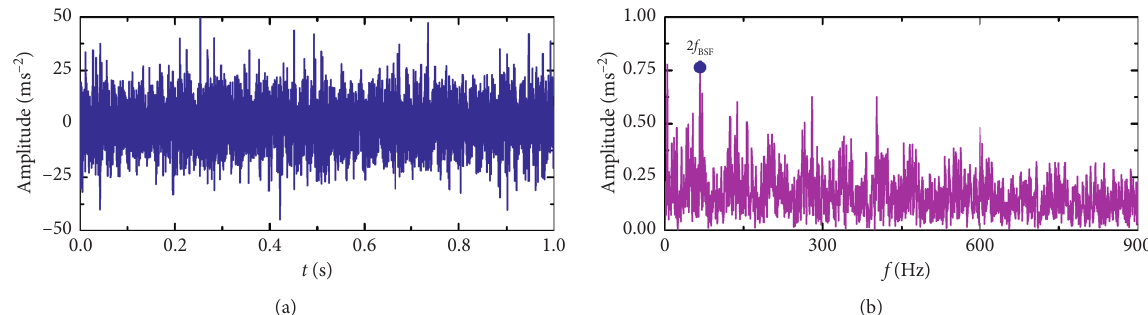
Figure 18: The collected roller fault signal and its Hilbert envelope spectrum: (a) time-domain waveform and (b) Hilbert envelope spectrum of signal in